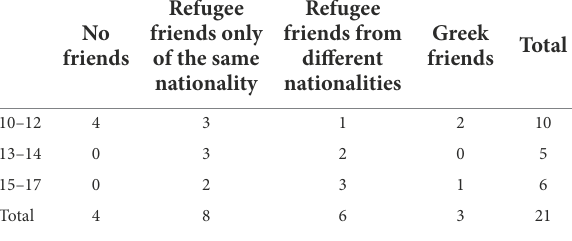
Children with ‘Refugee friends from different nationalities’ also have ‘Refugee friends of the same nationality’ and children with ‘Greek friends’ also have ‘Refugee friends of different nationalities’ and ‘Refugee friends of the same nationality’.